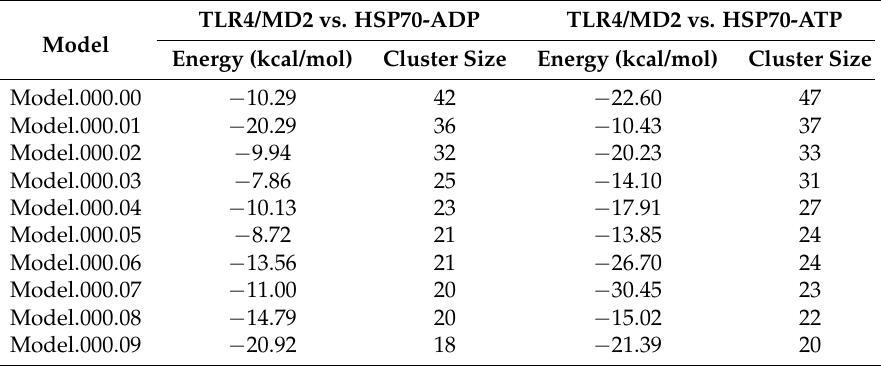
Table 2. Interacting energy (kcal/mol) and cluster size (n) of the top ranked docking conformations generated in the web server ClusPro 2.0.